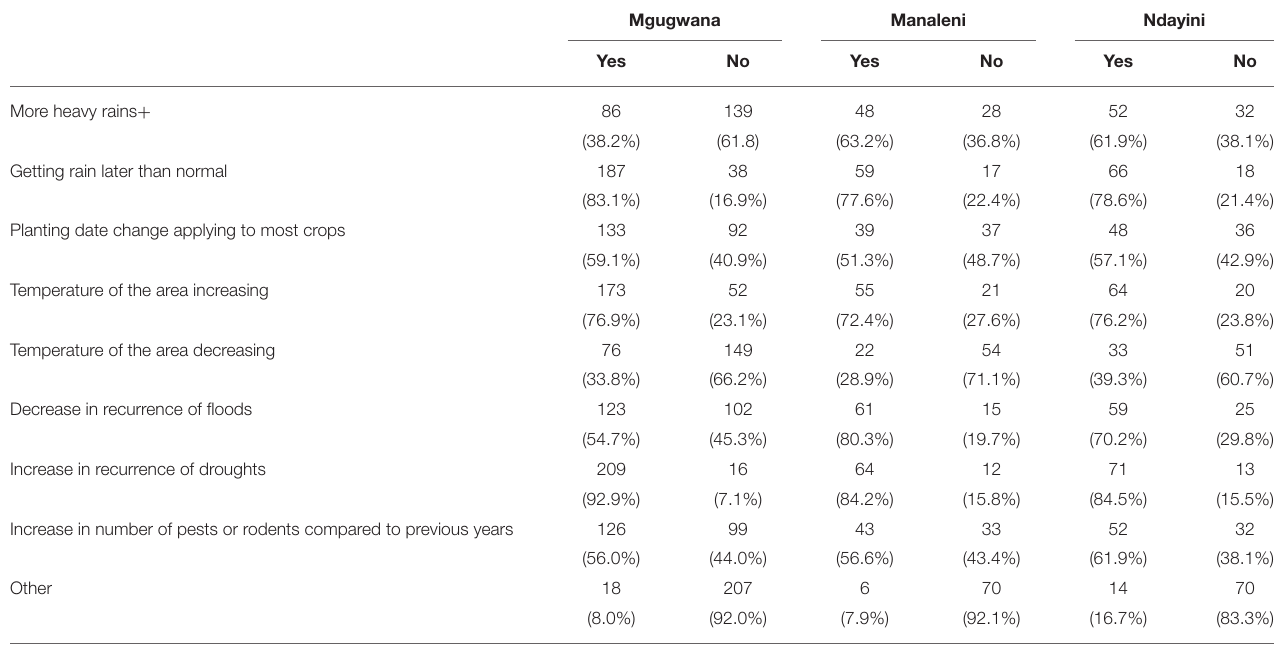
TABLE 4 | Experience with climate change on farming in the past 15 years.